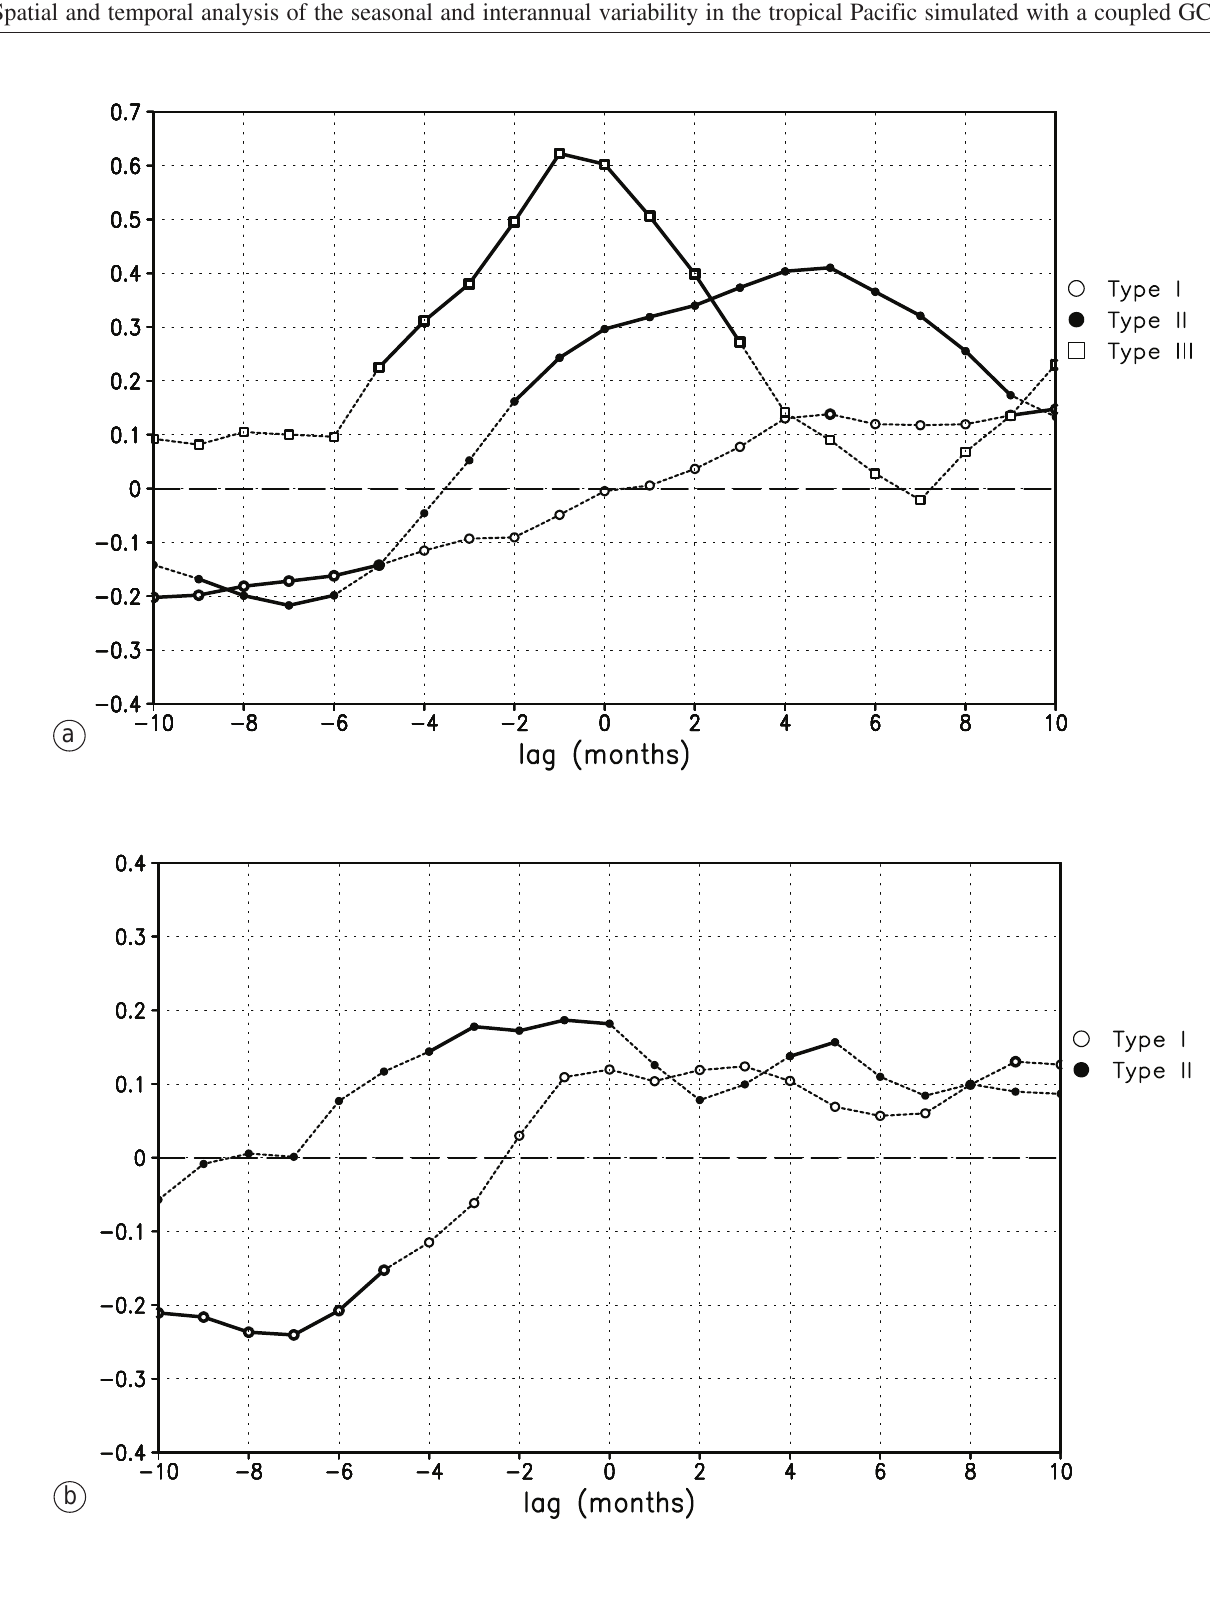
Fig. 8a,b. a) Lagged correlation between the SINTEX simulation GG and Niño3 Indices (GG leading at negative lags). Different time series have been formed by isolating the periods of occurrence of the distinct types of warm ENSO events. Solid thick lines correspond to correlation values significantly greater than zero at the 5% level; b) as in (a), now for cold ENSO